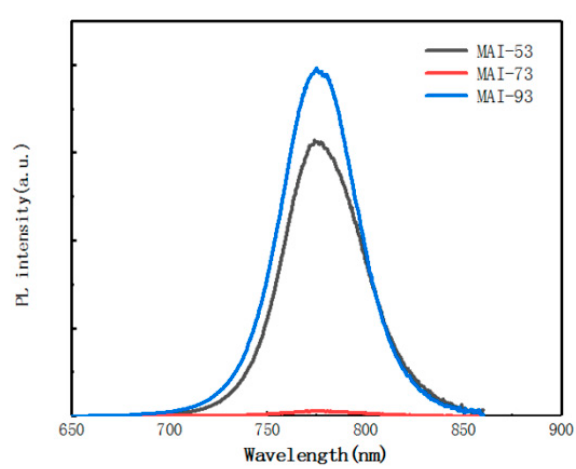
Figure 9. Photoluminescence spectra of organic–inorganic hybrid perovskite films with different concentrations of MAI precursor solution. Table 2. The full width at half maximum (FWHM) and emission peak center of photoluminescence spectra.